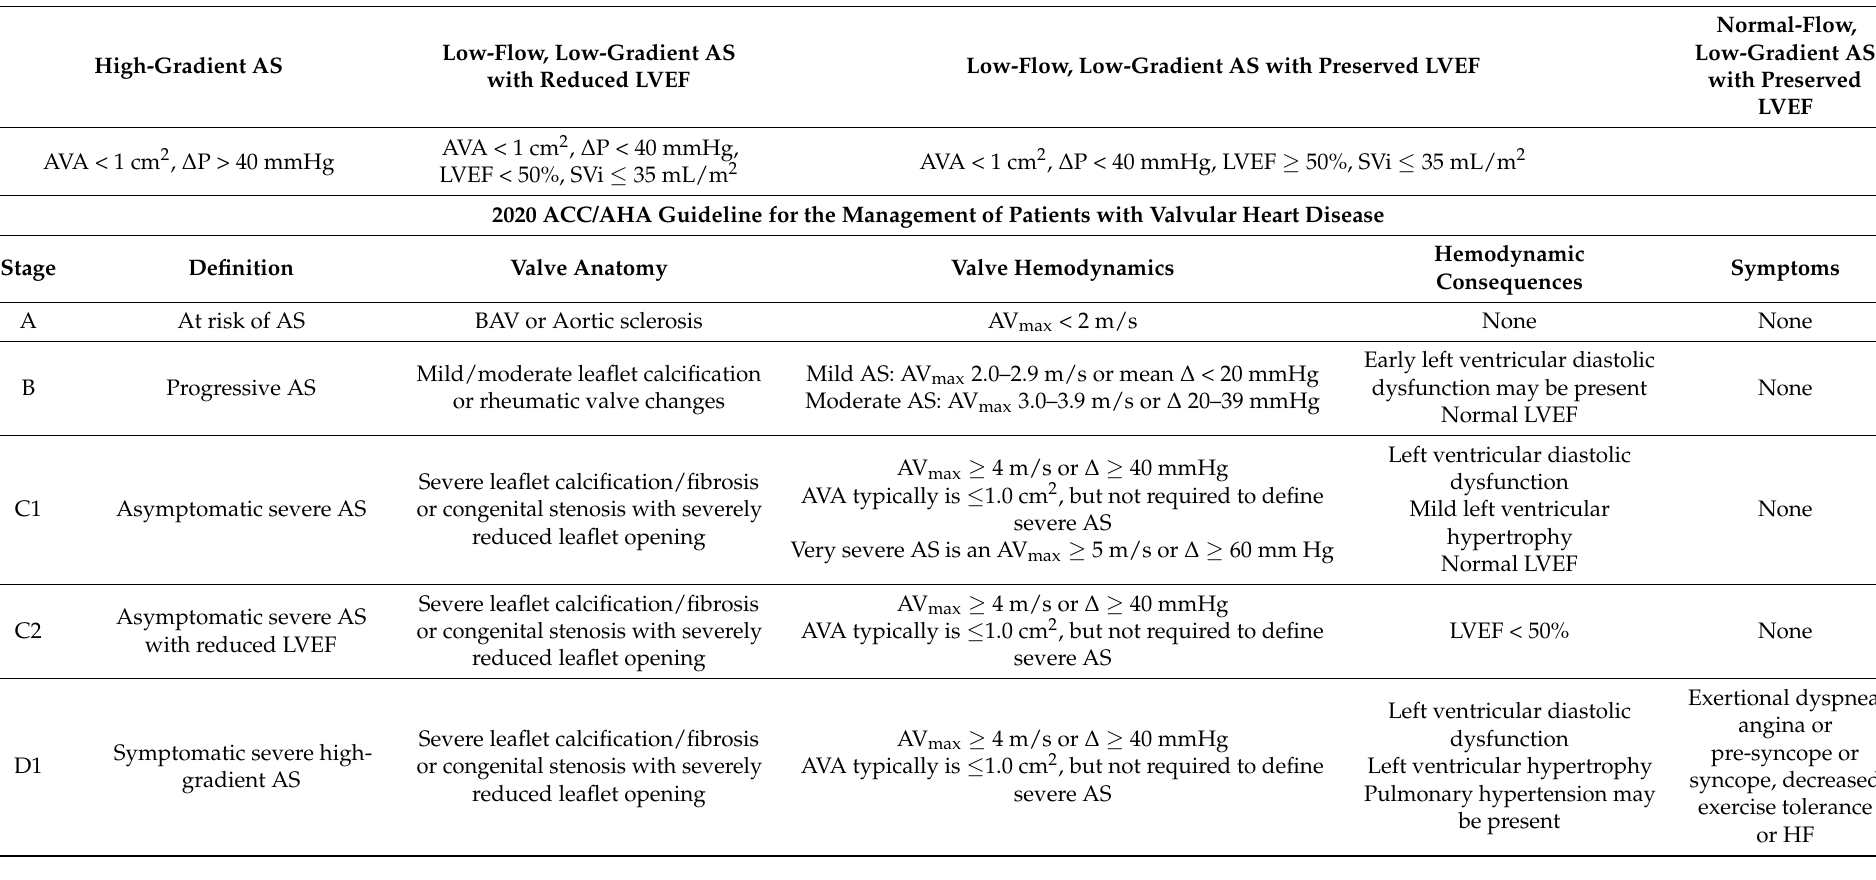
Table 2. Comparison between the different classification systems of the severity of AS in the European and American guidelines. 2017 ESC/EACTS Guidelines for the Management of Valvular Heart